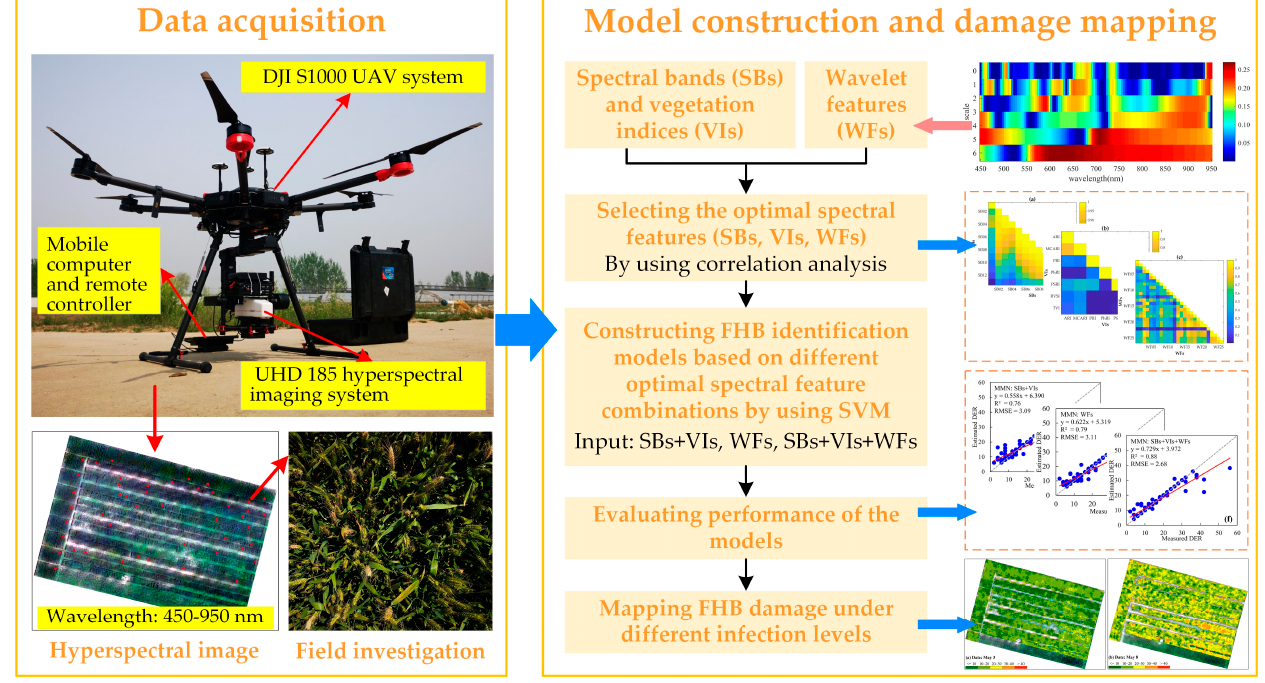
Figure 2. Methodological framework of wheat FHB detection model.